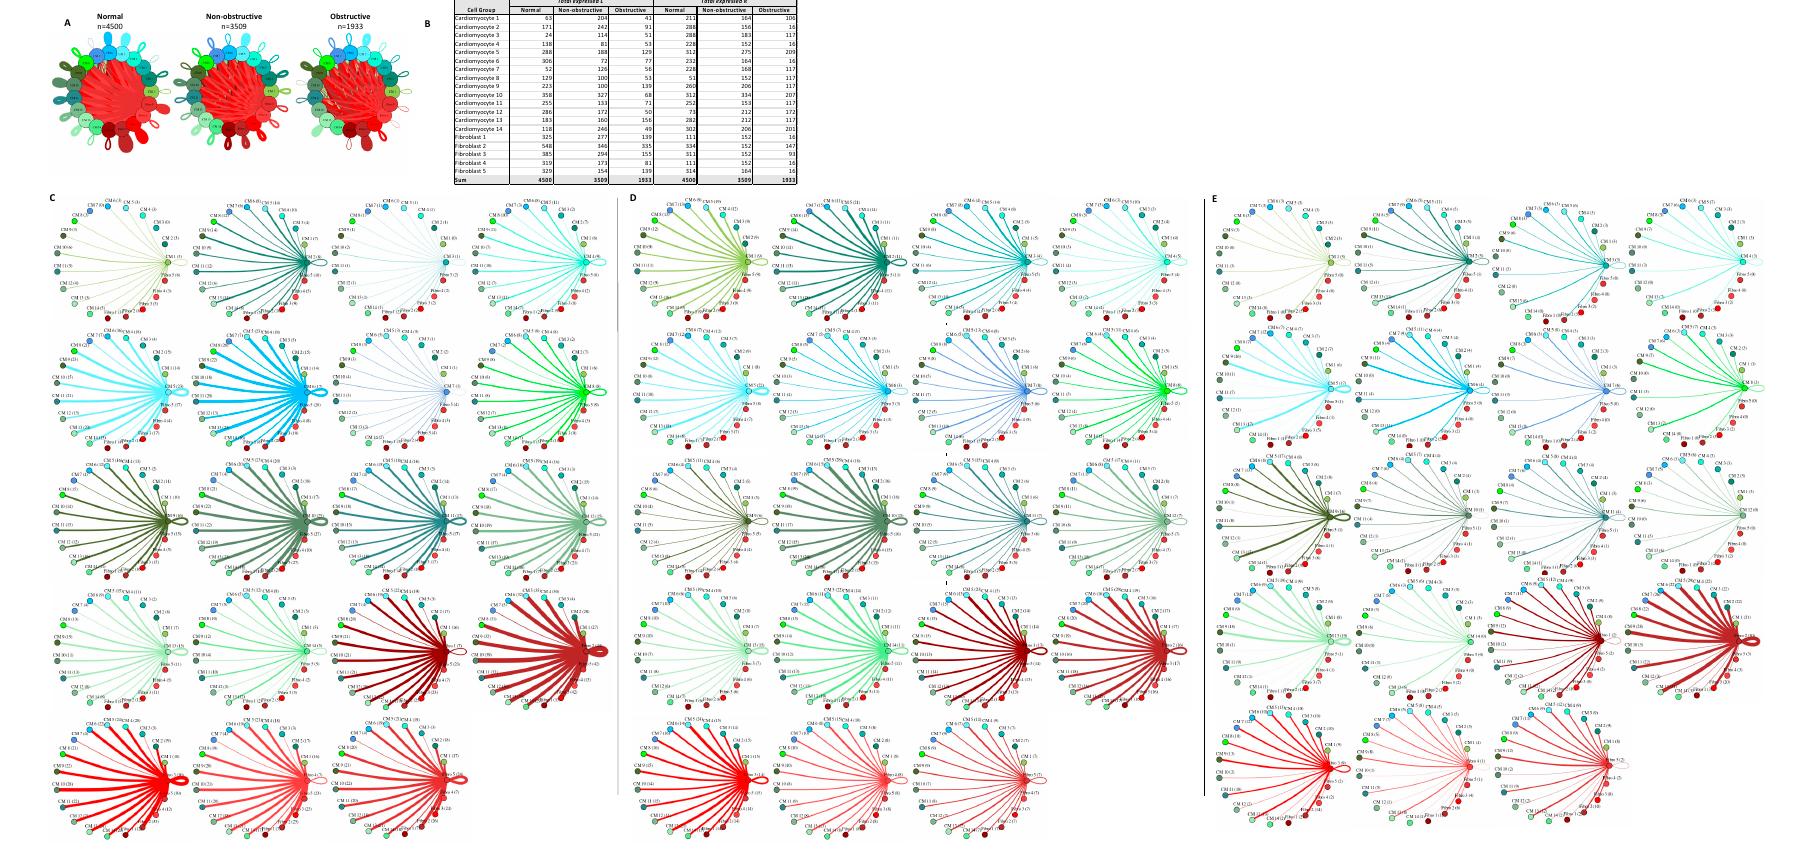
Figure 9. Cell–cell communication networks between cardiac fibroblast and cardiomyocyte subtypes in normal control, nonobstructive HCM, and obstructive HCM conditions. ( A ) Overall communication networks between normal, nonobstructive, and obstructive HCM cardiomyocytes and fibroblasts. Line color indicates ligand broadcast by the cell population with the same color. Lines connect to cell types which expressed cognate receptors. Line thickness is proportional to the number of uniquely expressed ligand–receptor pairs. Loops indicate communication within a cell type. ( B ) Quantity of ligands and receptors in expressed ligand–receptor pairs described by cell type and condition (normal, nonobstructive HCM, or obstructive HCM). ( C–E ) Cell–cell communication networks broken down by cardiomyocyte cluster and fibroblast cluster in normal control ( C ), nonobstructive HCM ( D ), and obstructive HCM ( E ) conditions. Figure formatting follows panel A. Numbers indicate the quantity of uniquely expressed ligand–receptor pairs between the broadcasting cell type (expressing ligand) and receiving cell type (expressing